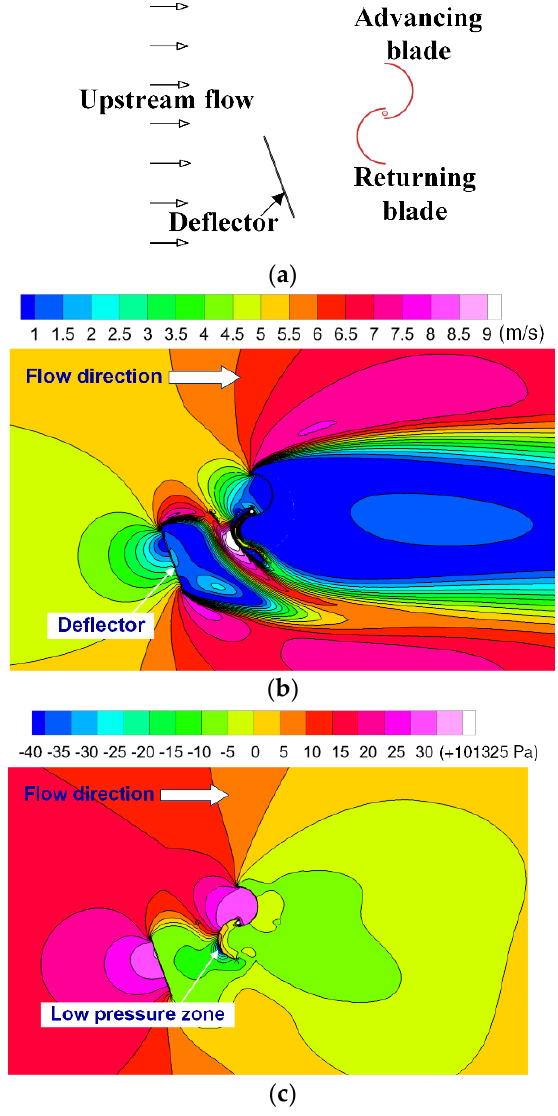
Figure 4. Cross-sectional flow parameter distributions with single deflector. ( a ) Single deflector scheme [28]; ( b ) Velocity distribution; ( c ) Static pressure distribution.